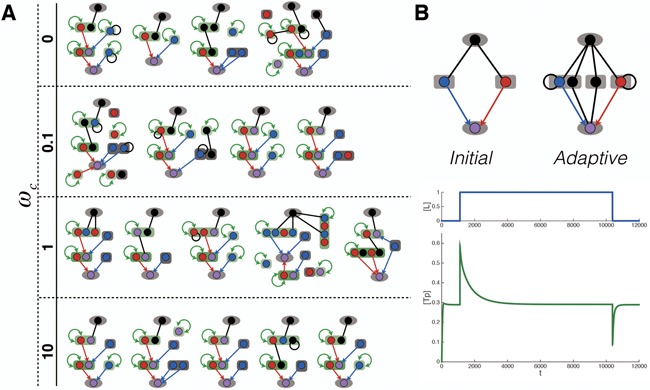
Sample evolved network structures and dynamics. (A) Sample network structures evolved to achieve ultrasensitivity in simulations with different weighting of the complexity score \documentclass[12pt]{minimal}
\usepackage{amsmath}
\usepackage{wasysym}
\usepackage{amsfonts}
\usepackage{amssymb}
\usepackage{amsbsy}
\usepackage{upgreek}
\usepackage{mathrsfs}
\setlength{\oddsidemargin}{-69pt}
\begin{document}
}{}$\omega _c$\end{document}. In each network, the nodes stand for proteins and edges stand for interactions. The isolated (i.e. unconnected) nodes seen on some of the evolved networks represent proteins that do not interact with any other proteins (hence they can be removed without affecting the response dynamics). For explanation of labels and edge colors see legend of Figure 2. (B) An evolved network structure and its dynamics using selection for an adaptive response.